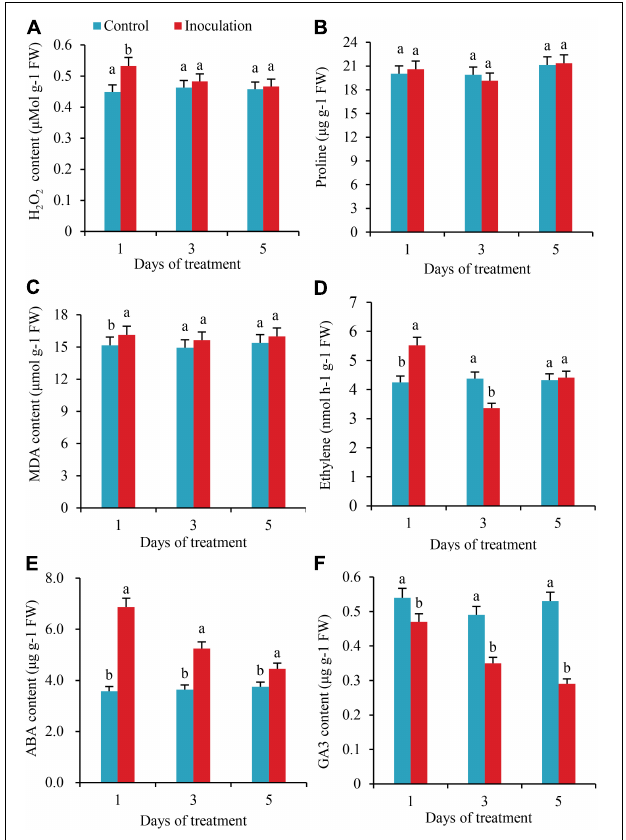
FIGURE 3 | Effect of inoculation with GXS16 on (A) H 2 O 2 , (B) Proline, (C) MDA, (D) Ethylene, (E) ABA, and (F) GA 3 . Values are mean, and vertical bars indicate the standard deviation of three replications. Means followed by the same letter within a column are not significantly different ( p < 0.05) according to Duncan’s multiple range test (DMRT). H 2 O 2 , hydrogen peroxide; MDA, malondialdehyde; ABA, abscisic acid; GA 3 , gibberellic acid.